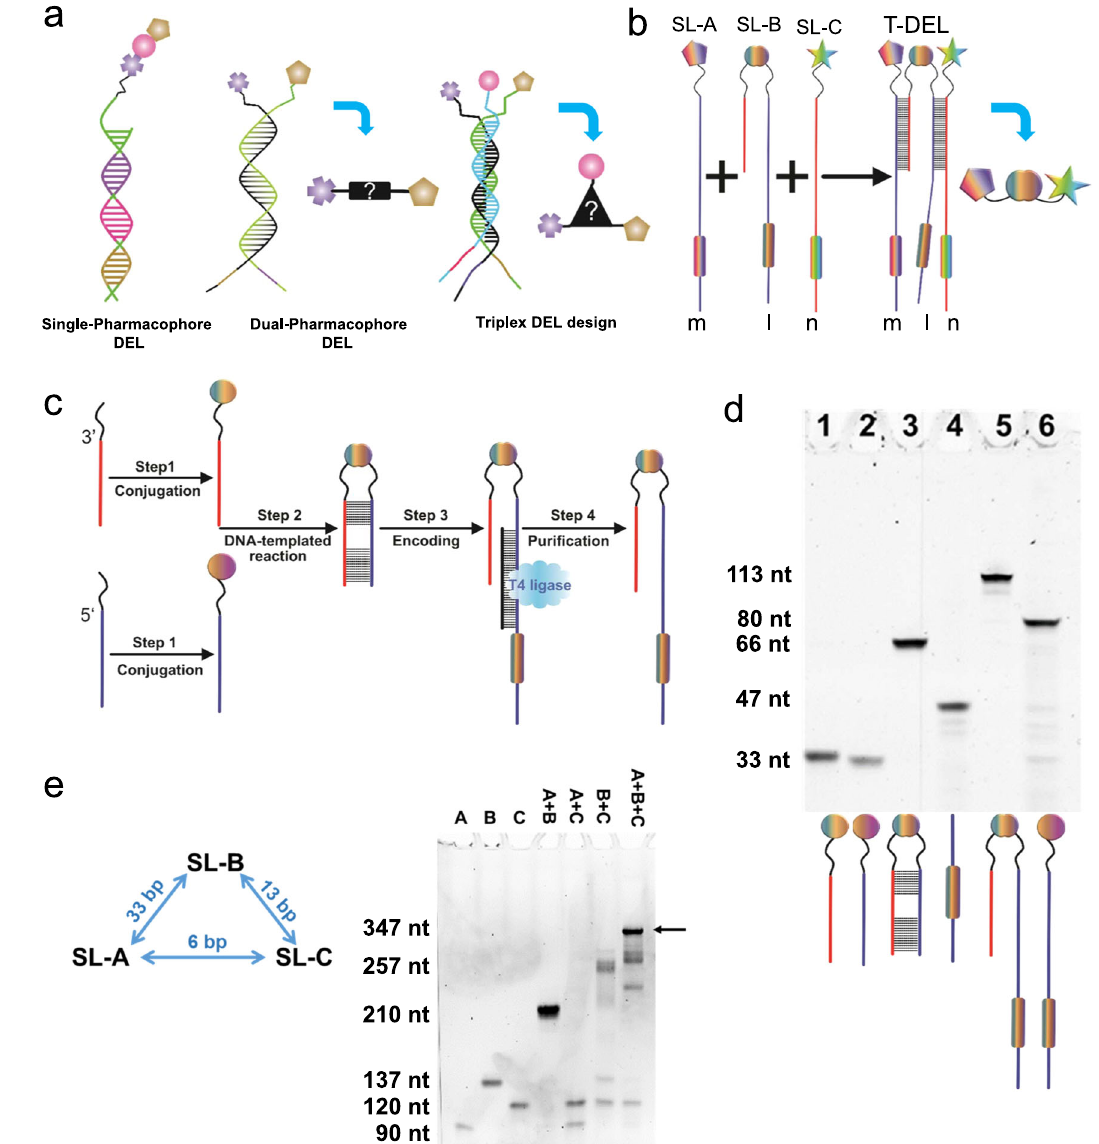
Fig. 1 | Trio-pharmacophore DNA-encoded chemical library. a Schematic representation of a single-pharmacophore, a dual-pharmacophore, and a triplex DELdesignproposedby Melkkoet al. Figureadapted from Melkko et al.2004 and 2007 29,30 . b Format of the trio-pharmacophore DEL (T-DEL) proposed in this work. c Synthetic scheme of sub-library B. The synthesis started from two oligonucleo- tides with functional groups at the 3 ’ and 5 ’ end. The two oligonucleotides shared 6+12 complementary base pairs. Step 1. Bi-functional building blocks were con- jugated to the oligonucleotides to generate single-side compound-DNAconjugate. Step 2. Conjugates from each side underwent DNA-templated reactions via the complementarity and the reactive functional groups from the building blocks. DNA-compound-DNA conjugates harboring both oligonucleotides were synthe- sized. Step 3. Eachconjugate was then encoded with a unique barcodeby using an adapter DNA (in black) and T4 DNA ligase. Step 4. The encoded conjugate was puri fi ed from the ligation solution to generate high purity library member of sub- library B. d Step-by-step monitoring of the library synthesis by urea-denaturing